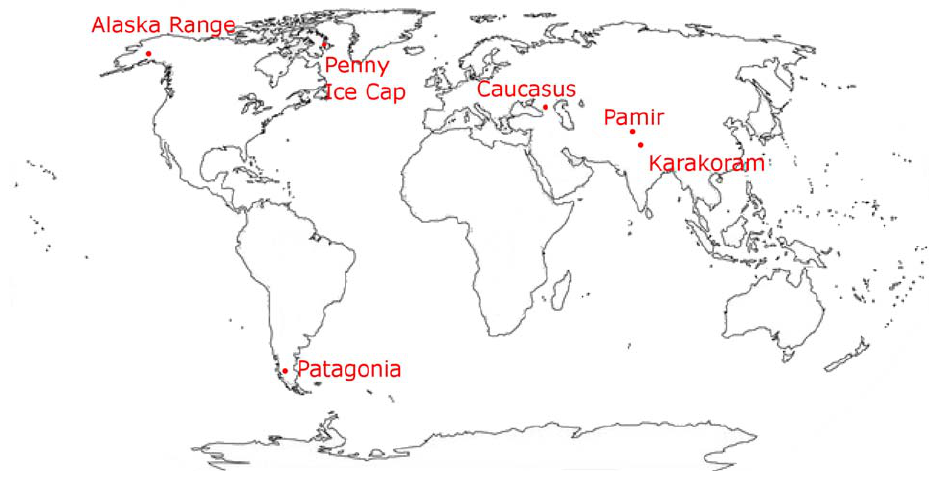
Fig. 1. Location of the six studied regions.